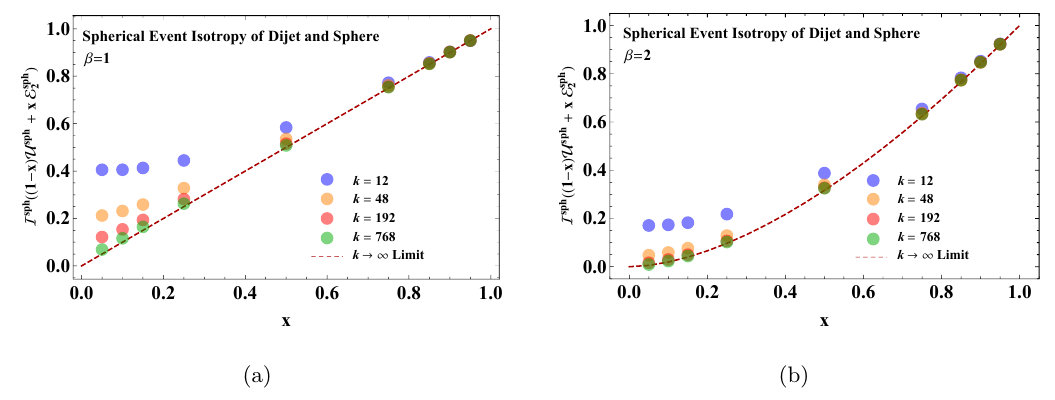
and (b) d (cid:12) =2 for back-to-back two- ij ij